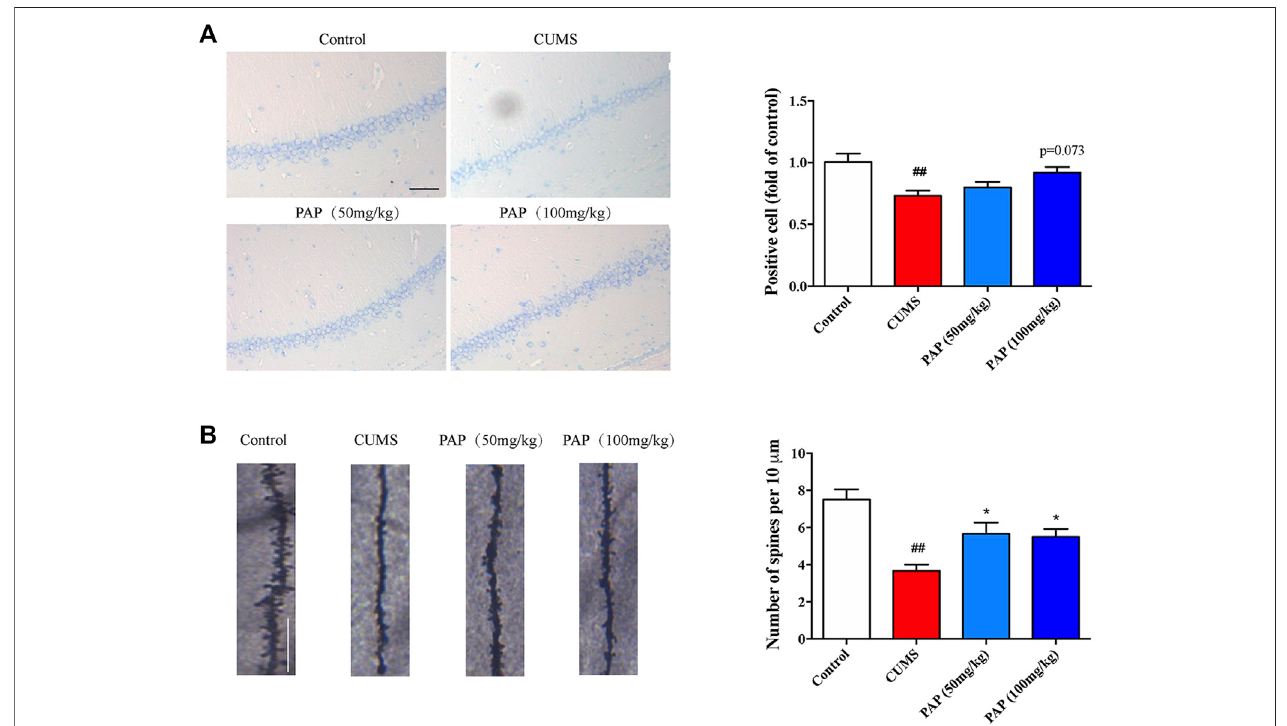
FIGURE2| Effect ofPAPon theNisslbody anddendriticspinedensity. The positivecellinNissl staining (A) andthe number ofspines per10 μ m 2 (B) ofGolgi-Cox staining. ## p < 0.01 vs. control group and * p < 0.05 vs. CUMS group. Scale bar: 100 μ m (A) , 10 μ m (B) .